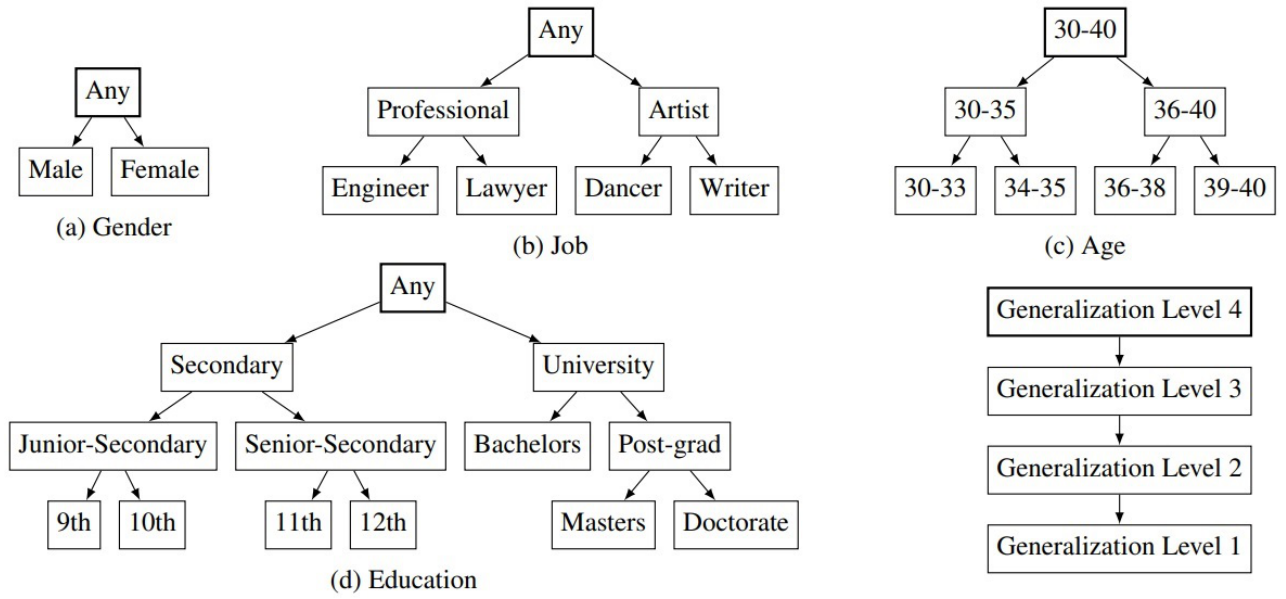
Figure 1. Examples of Taxonomy Trees.